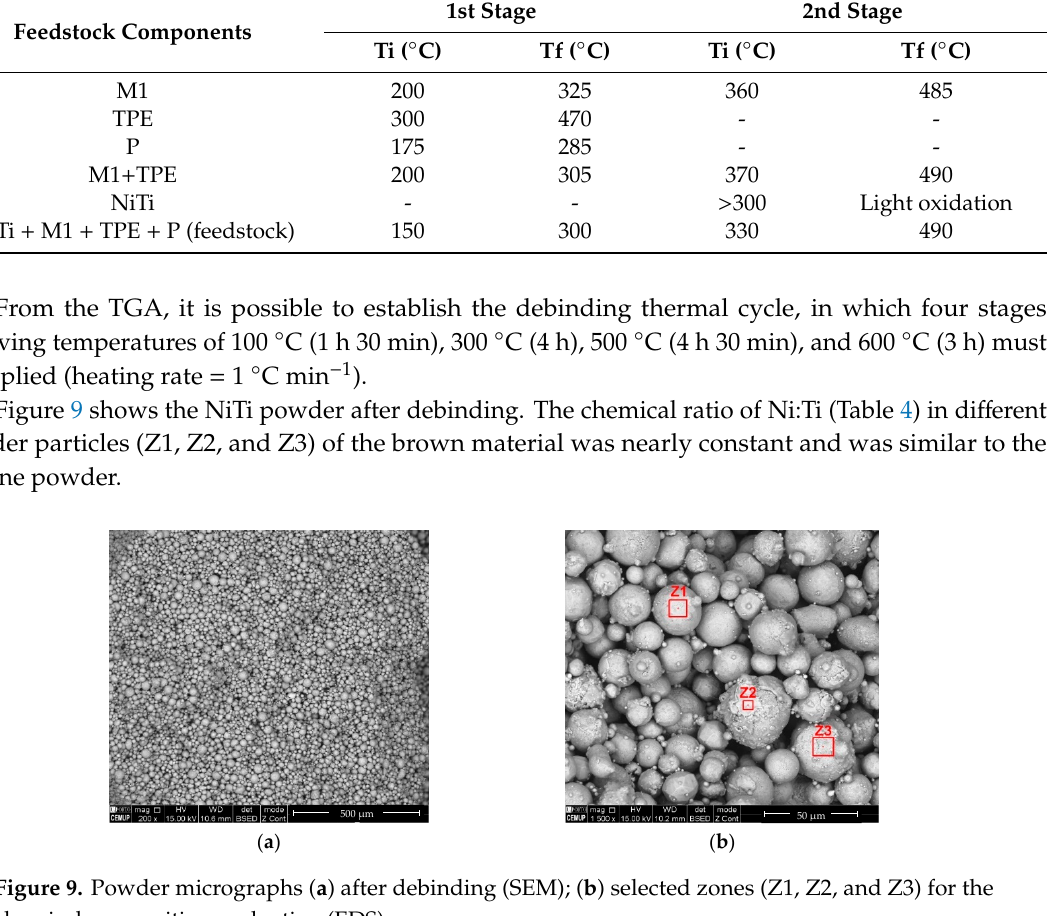
Figure 8. Thermal gravimetric analysis of the binder, additives, and mixed and unmixed NiTi. From the TGA, it is possible to establish the debinding thermal cycle, in which four stages involving temperatures of 100 °C (1 h 30 min), 300 °C (4 h), 500 °C (4 h 30 min), and 600 °C (3 h) must be applied (heating rate = 1 °C min − 1 ). Table 3. Start and end temperatures of the different debinding steps.